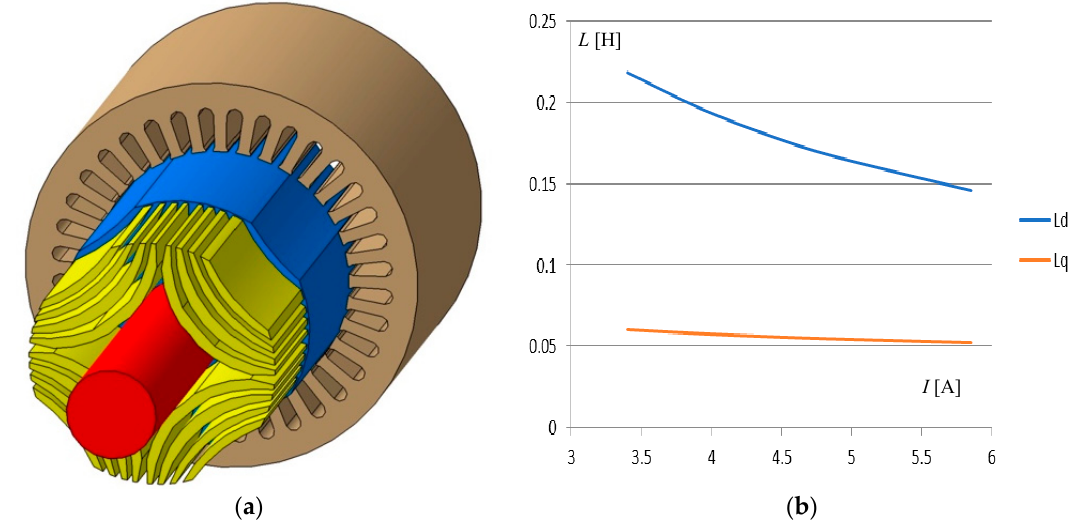
Figure 1. ( a ) Semi-exploded view of optimized and designed rotor (yellow means air barriers), ( b ) Synchronous inductances versus phase current to show effect of saturation.